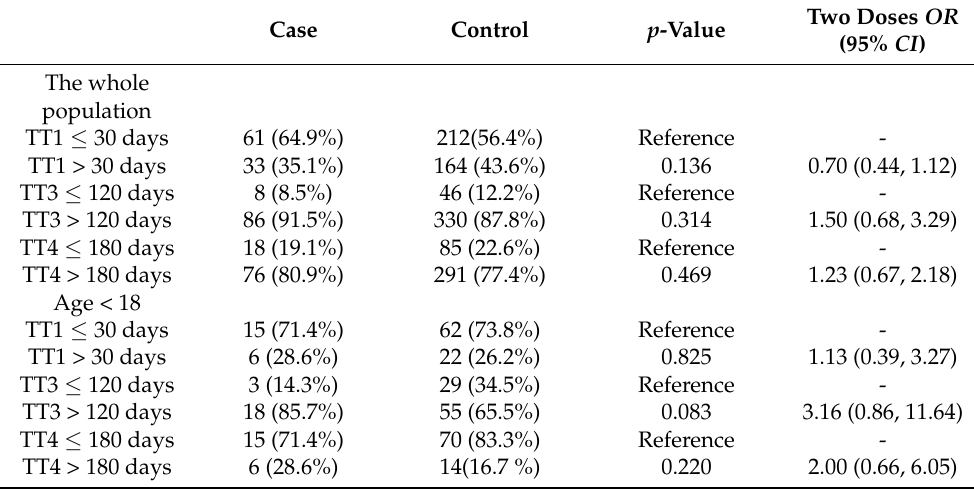
Table 4. The association between vaccination intervals and SARS-CoV-2 infection among those who received two vaccine